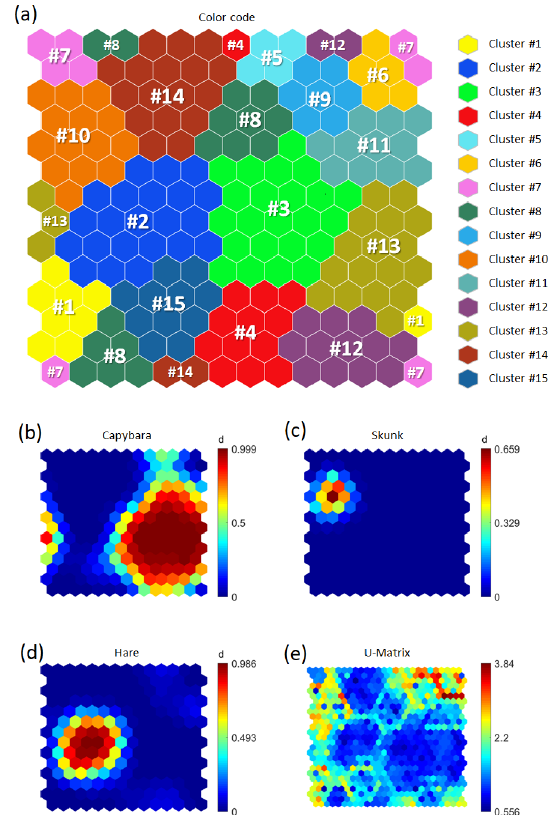
Figure 5. (a) Clustering of 15 regions with high similarity obtained based on the (e) U-Matrix and three examples for (b) capybara, (c) skunk, and (d) hare, respectively. In these three examples, the red color indicates a high concentration of